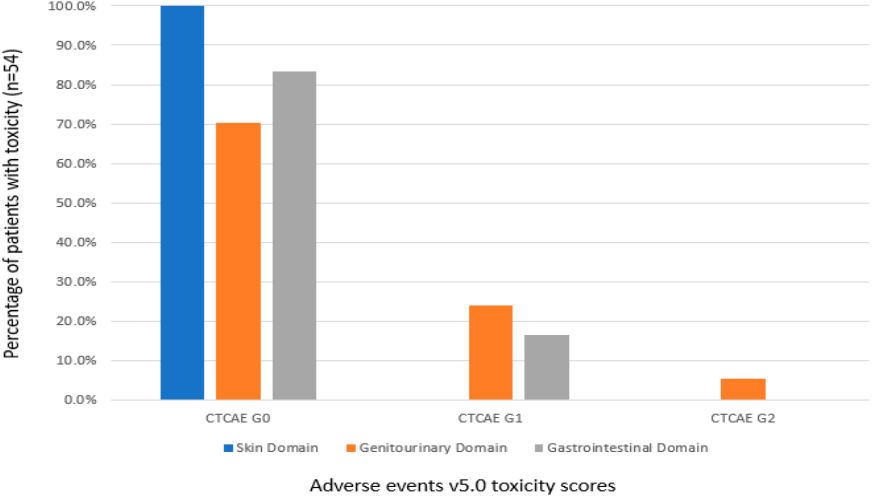
Figure 2. Maximum common terminology for adverse events v5.0 (CTCAE v5.0) toxicity scores at any time post-radiotherapy in the skin (blue), genitourinary (orange) and gastrointestinal (grey) domains.